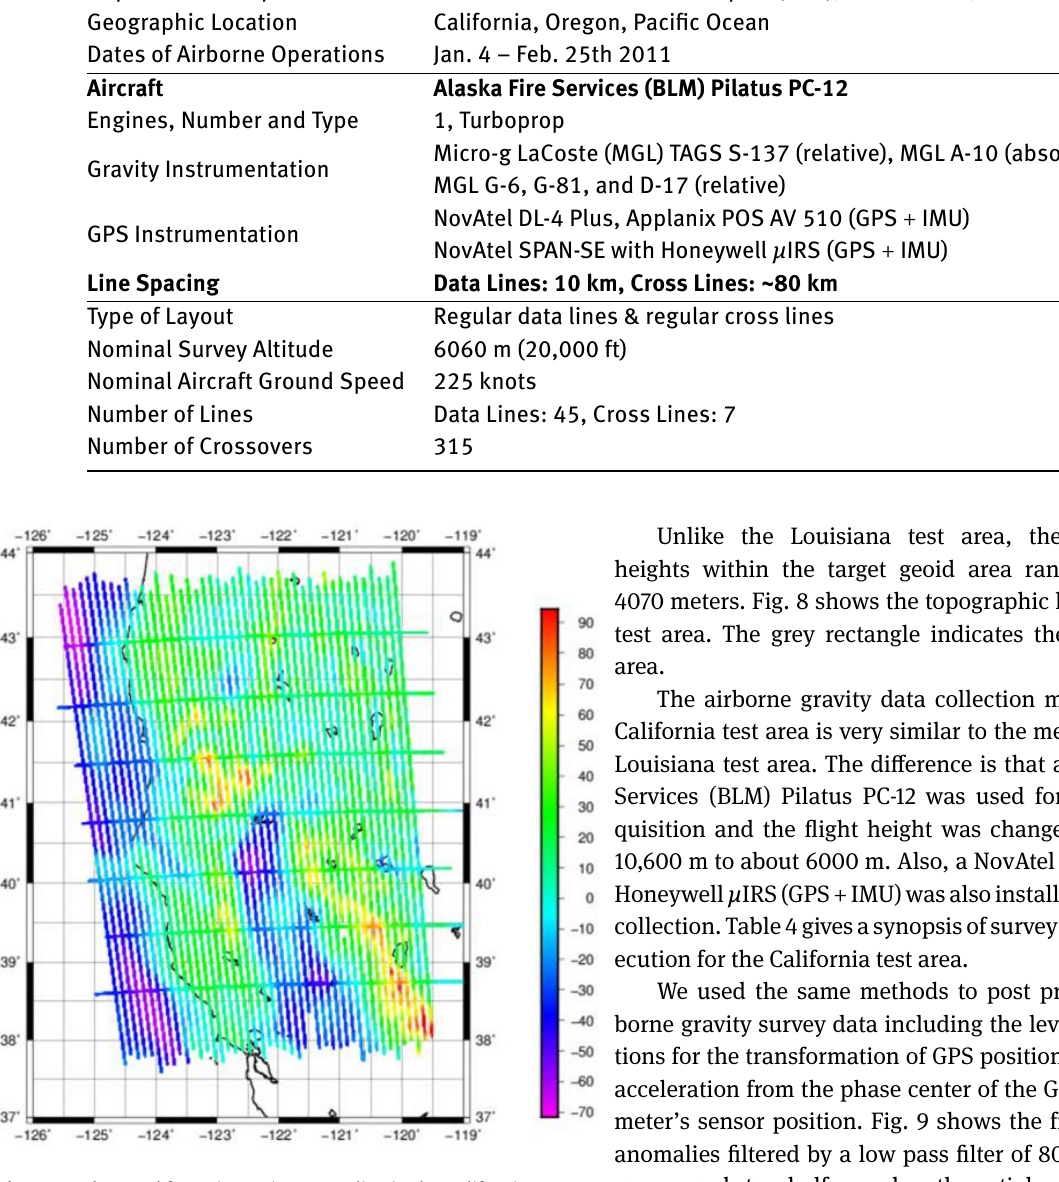
Figure 9: Observed free-air gravity anomalies in the California test area ranges from − 80 to 90 mGal